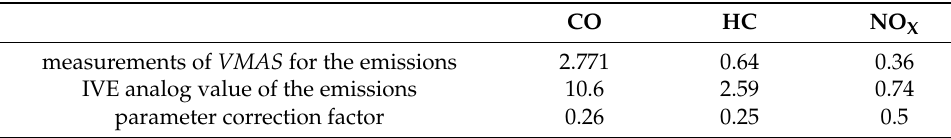
Table 5. Modification factor of taxi IVE in Qingdao (g/km).